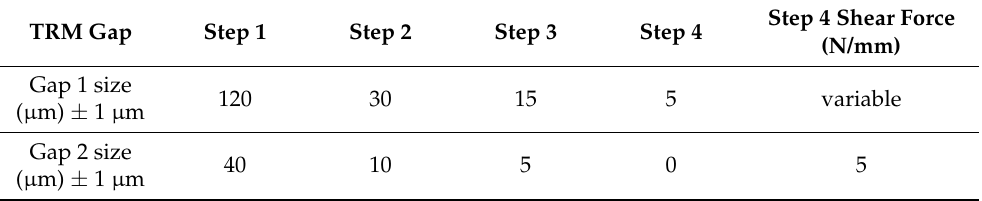
Table 1. Overview of the used gap sizes for all three-roll mill processes.